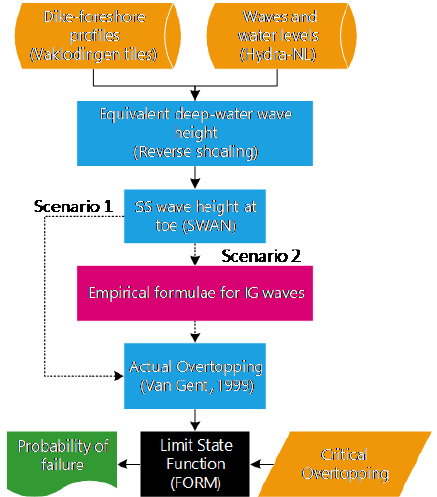
Figure 2. Model framework highlighting Scenario 1, which consid- ers only the influence of SS waves, and Scenario 2, which considers both SS and IG waves (see Sect. 2.2.5 for further scenario descrip-